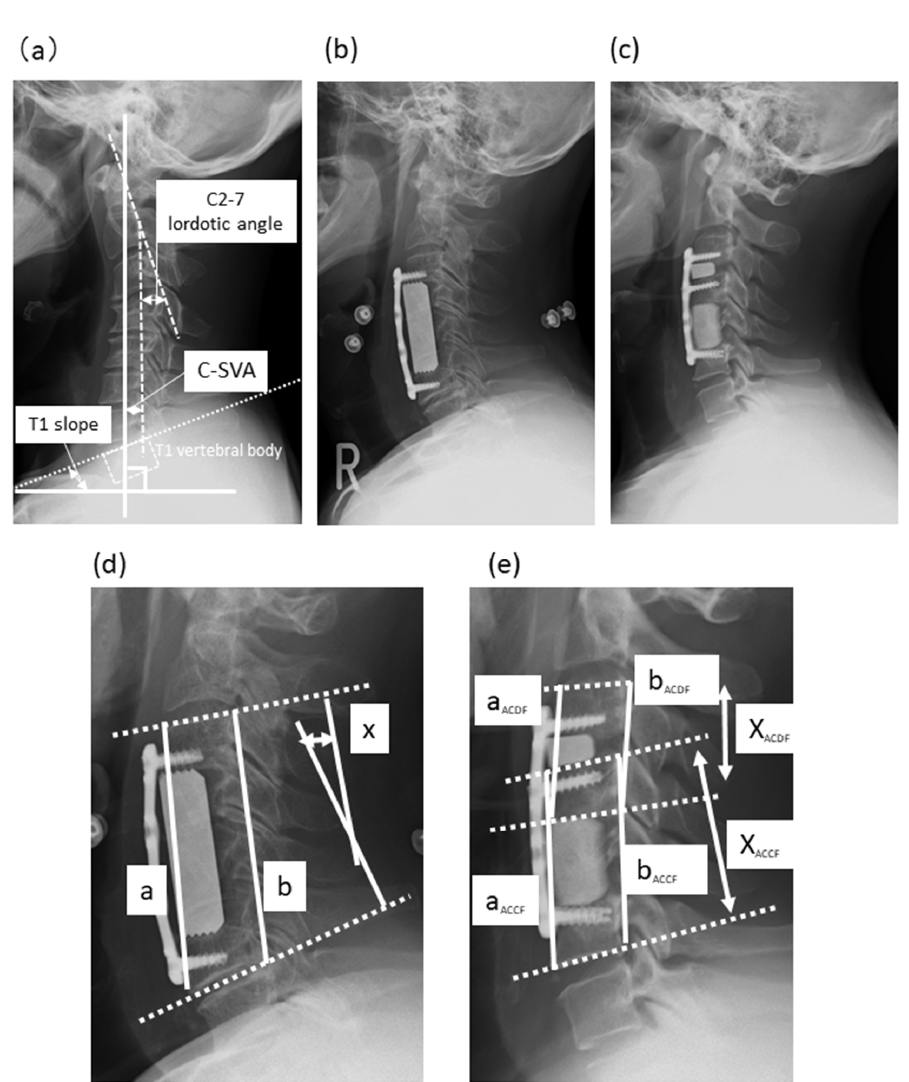
Figure 1. Long semi-constrained plate fixation with artificial bone graft. ( a ) Preoperative radiograph showing the C2–7 lordotic angle, C-SVA, and T1 slope. Postoperative radiographs ( b ) after dual-level corpectomy (C4–5) and ossification floating decompression and ( c ) with dual artificial bone graft after discectomy (C3/4) and single corpectomy (C5). ( d ) Postoperative radiograph showing fused segment angle and fused segment height in the ACCF group. ( e ) Postoperative radiograph showing fused segment angle and fused segment height in the hybrid